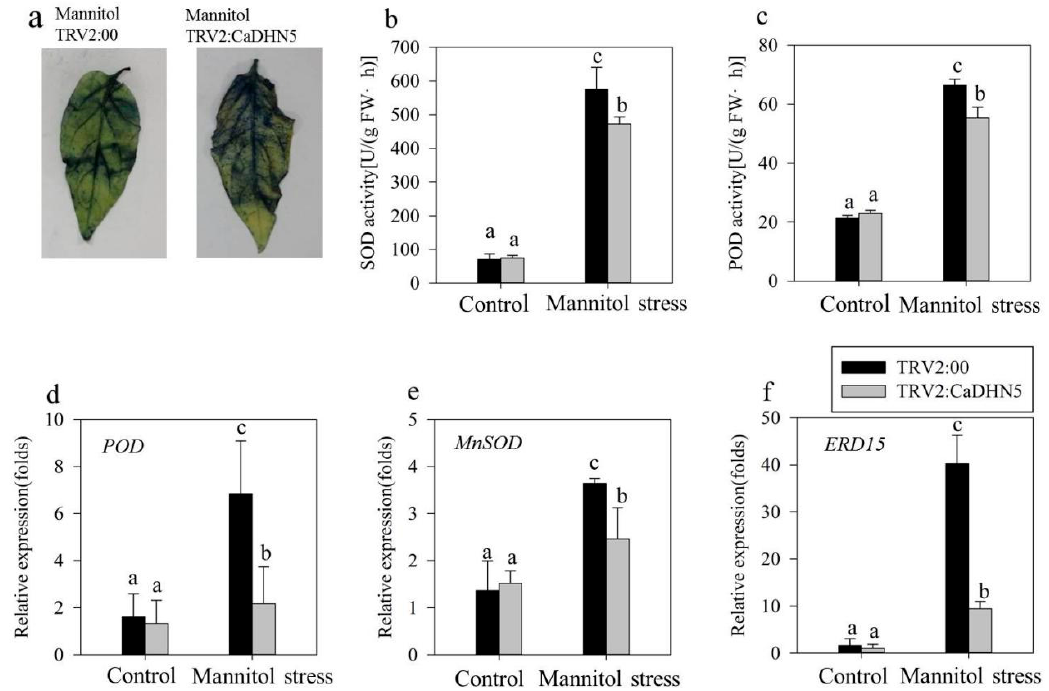
Figure 3. Determination of oxidative stress resistance and stress-related gene expression in mannitol treatment. ( a ) Results of pepper plants stained with NBT under mannitol treatment; ( b ) SOD activity under osmotic stress; ( c ) POD activity under mannitol treatment; ( d ) relative expression of POD under mannitol treatment; ( e ) MnSOD relative expression under mannitol treatment; ( f ) relative expression of ERD15 under mannitol treatment. Data that are significantly different are indicated with letters above the error bars (±S.D.). The different letters with the bars indicate significant differences as determined using Tukey HSD’s multiple range tests ( p < 0.05).